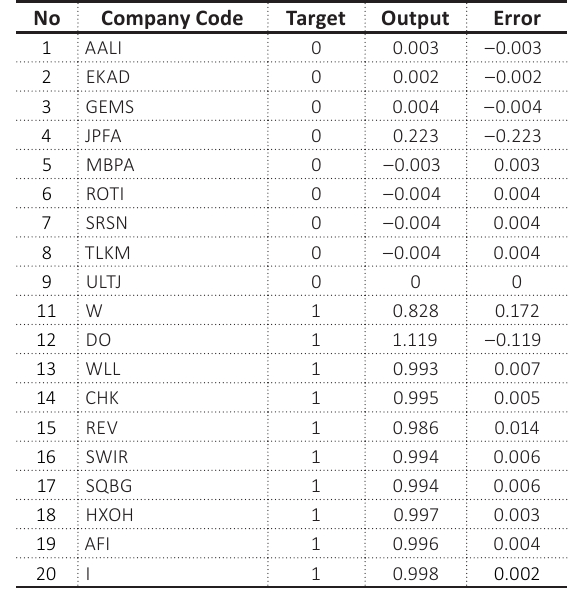
Table 5. Training data output